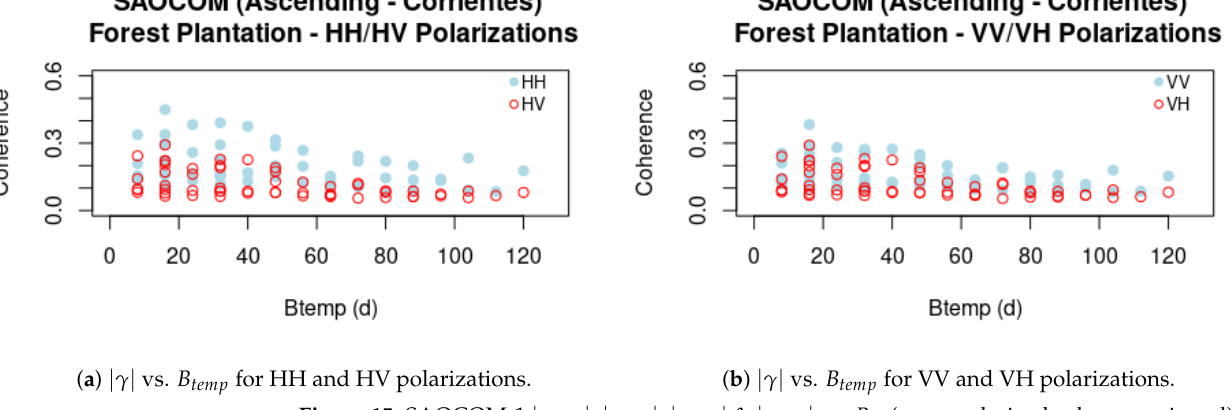
Figure 15. SAOCOM-1 | γ HH | , | γ VV | , | γ HV | & | γ VH | vs. B ⊥ (cross-polarized coherences in